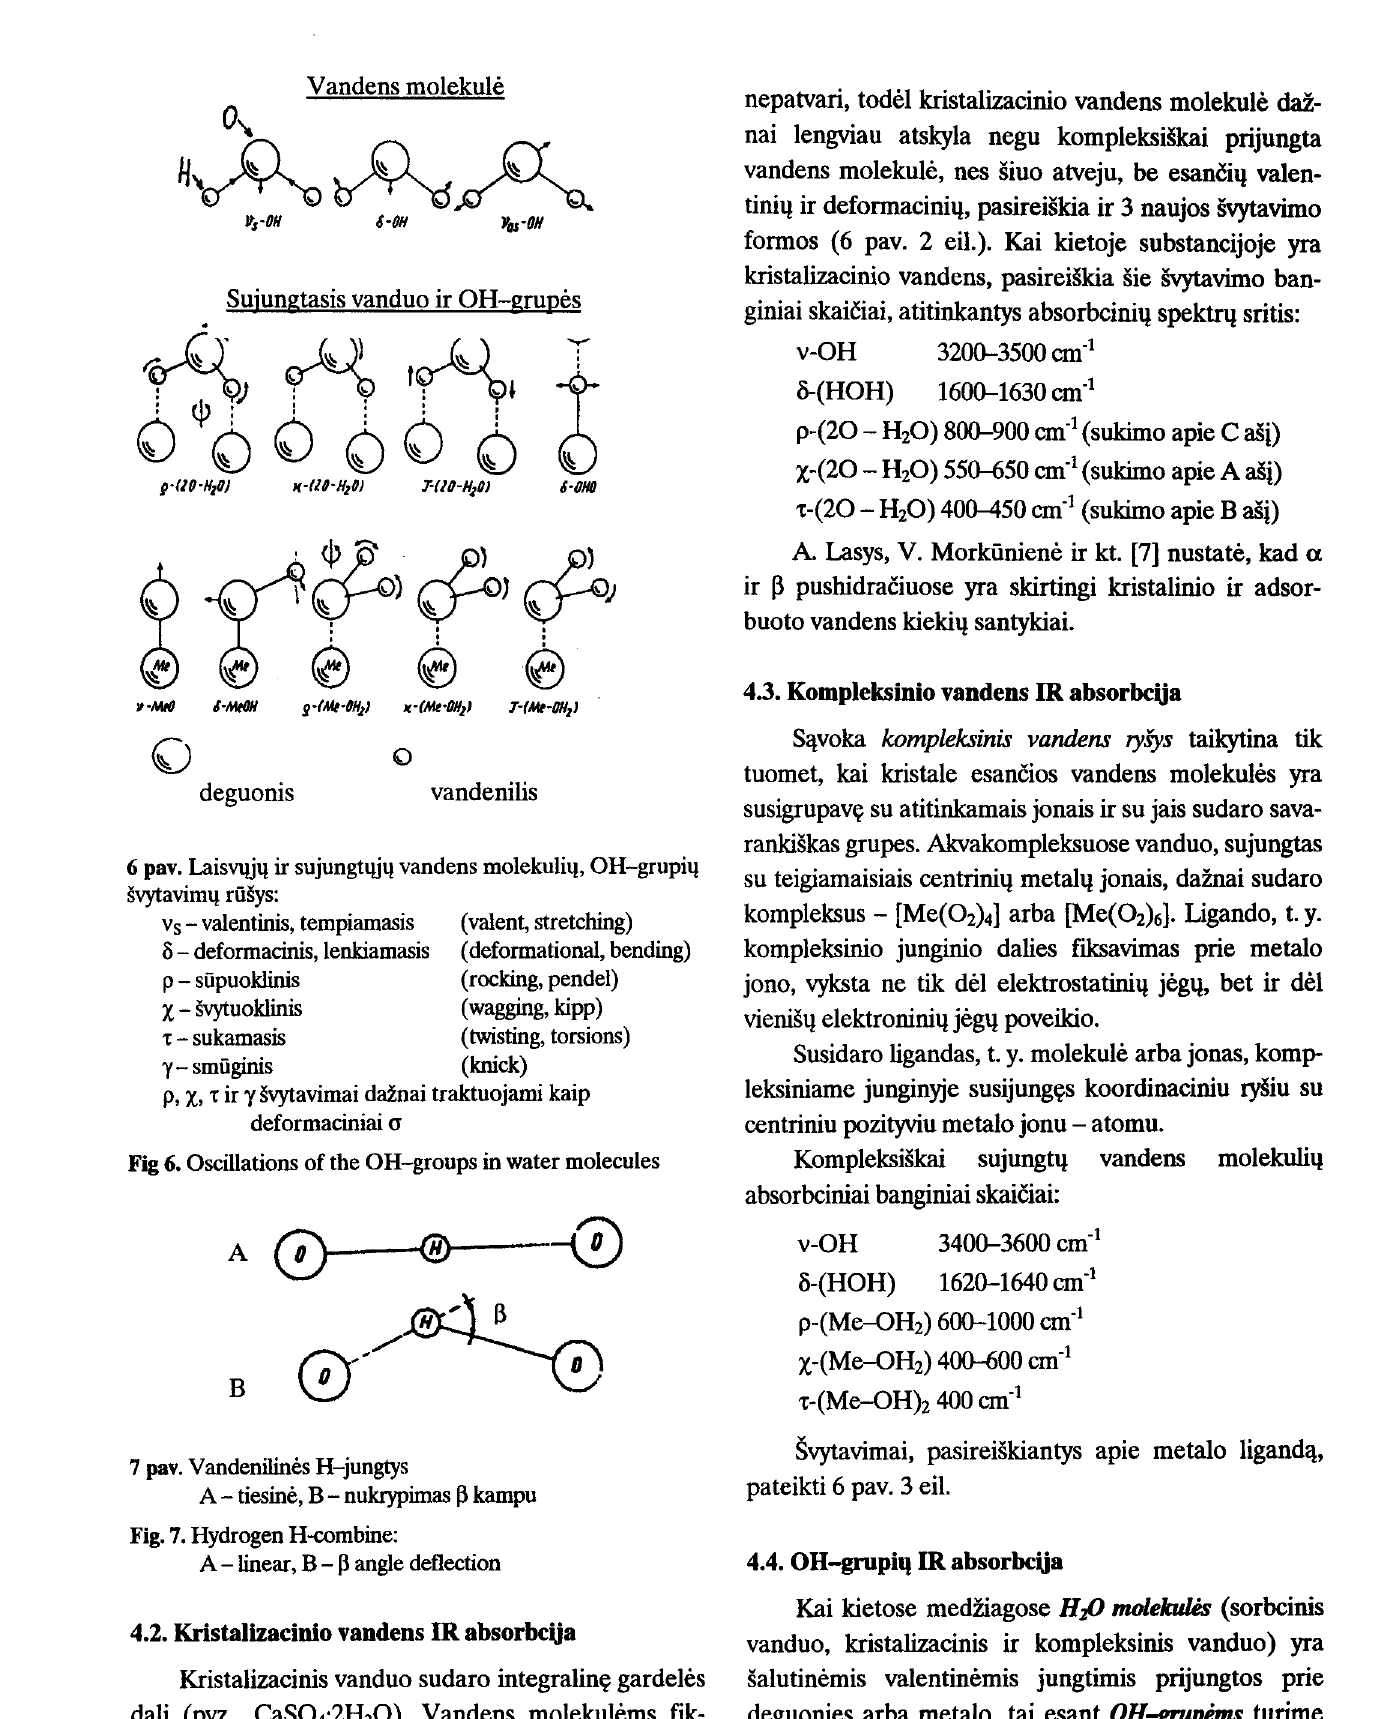
Fig. 7. Hydrogen H-combine: A -linear, B- ~ angle